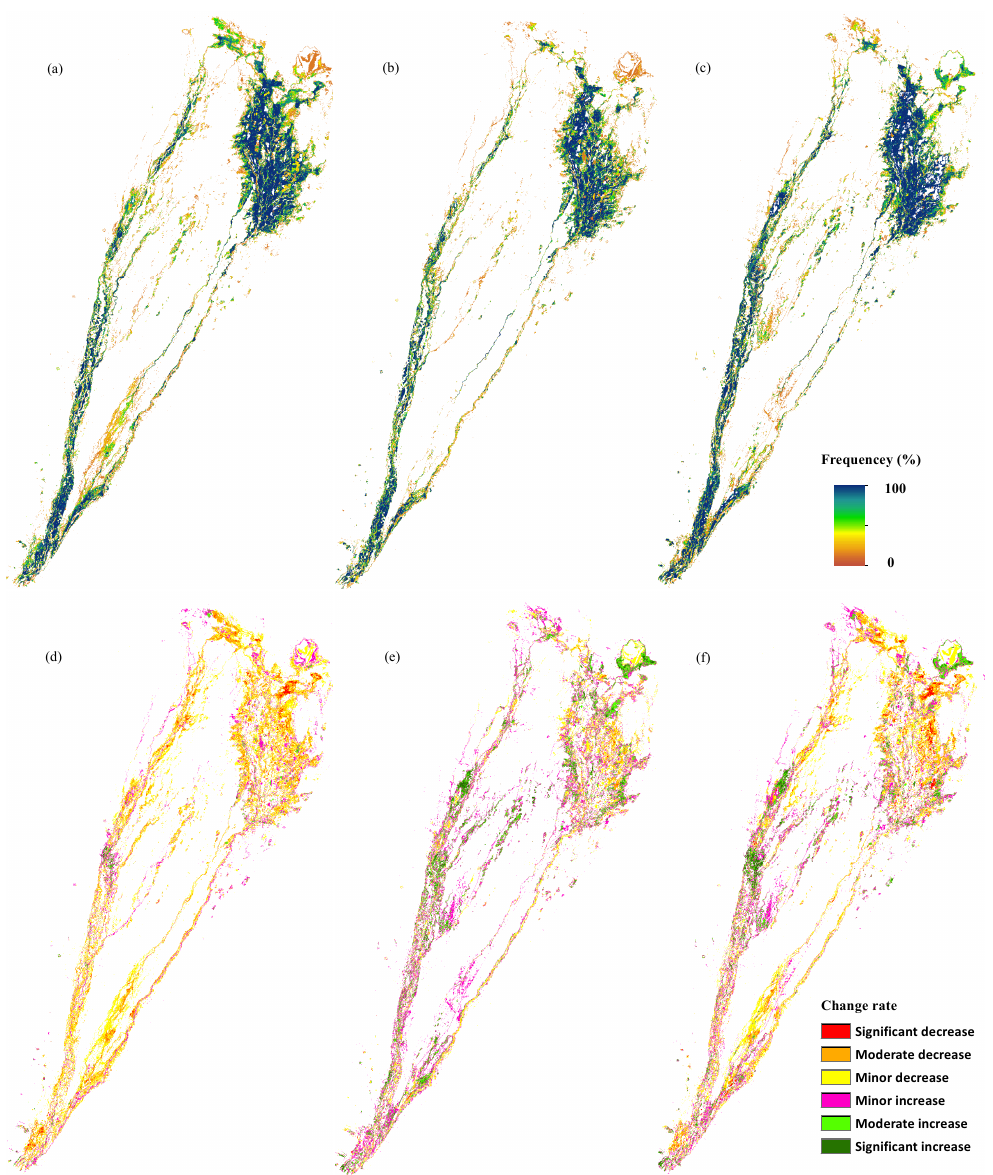
Figure 5. Spatial distribution of vegetation-covered regions in Ejina Oasis. The upper row shows the frequency of vegetation distribution for the three periods: (a) period 1 (1988–1998, no data were available for 1989 and 1997, data for 1993 were excluded for their poor quality), (b) period 2 (2000–2007) and (c) period 3 (2008–2015). The lower row shows the corresponding changes between the pairs of periods: (c) changes between periods 1 and 2, (d) changes between periods 2 and 3 and (e) changes between periods 1 and 3.